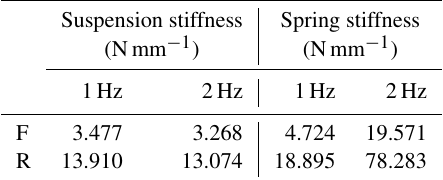
Table 5. Conversion of suspension stiffness to spring